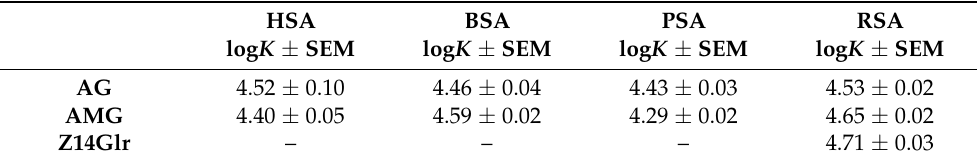
Figure 2. Representative fluorescence emission spectra of albumins, and the quenching effects of alternariol - 3 - glucoside (AG): Impacts of increasing concentrations of AG (0–5 μM) on the emission signals of human (HSA; ( A )), bovine (BSA; ( B )), porcine (PSA; ( C )), and rat (RSA; ( D )) serum albumins in PBS (pH 7.4; albumin concentration: 2 μM; λ ex = 295 nm). Table 2. Decimal logarithmic values of binding constants ( K ; L/mol) of mycotoxin–albumin com- plexes, determined based on fluorescence quenching experiments ( n =